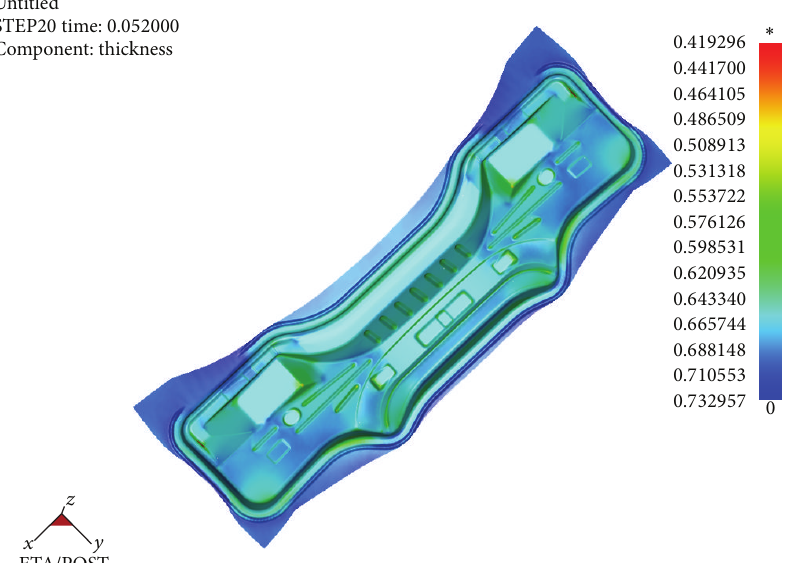
Figure 8: Thickness distribution of the forming parts for A3B1C1D3 optimized scheme.